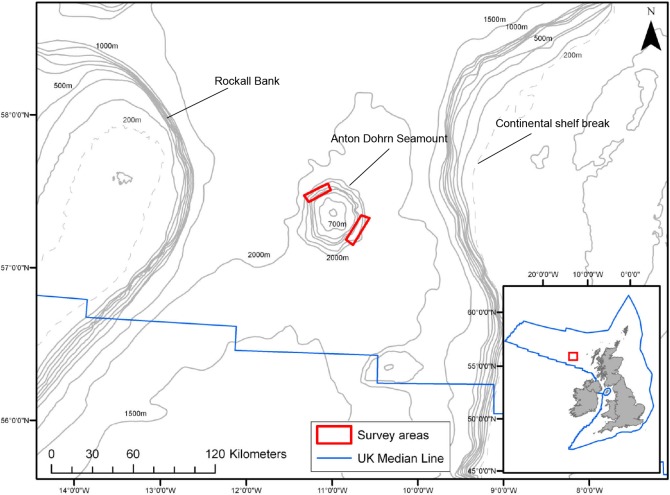
The study area west of Scotland, UK.Survey areas on the NW and SE sides of Anton Dohrn Seamount are marked. Bathymetric contours are provided by GEBCO, the 200 m depth contour (dashed line) marks the approximate position of the continental shelf break.